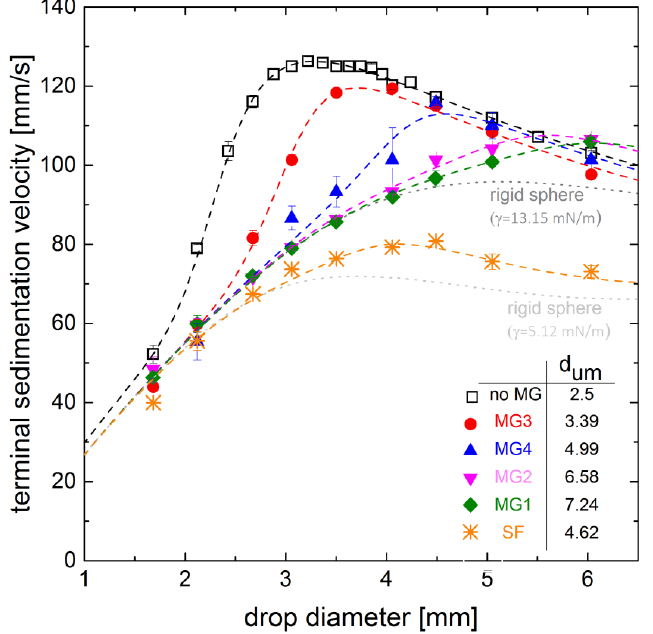
Figure 3. Terminal sedimentation velocity of n -butyl acetate drops in water, drops covered with different microgels (MG) and surfactant (SF) (microgel properties summarized in Table 1, c MG = 0.047 g/L in the drop generator for all microgels and c SF ≫ cmc ), ( ◻ pure system, ◆ MG1, ▾ MG2, ● MG3, ▴ MG4 and ∗ surfactant (SF), dashed lines obtained by fitting to Henschke Model [19,20], transition parameter d um listed in